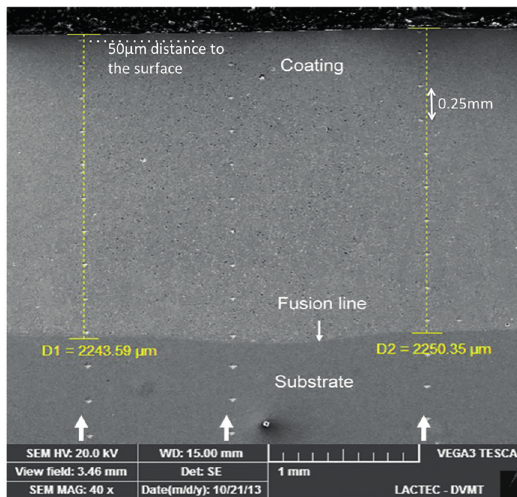
Figure 2: Cross-section of coating. Arrows indicate the rows of microhardness measurements and the fusion line Vickers microhardness measurements under a